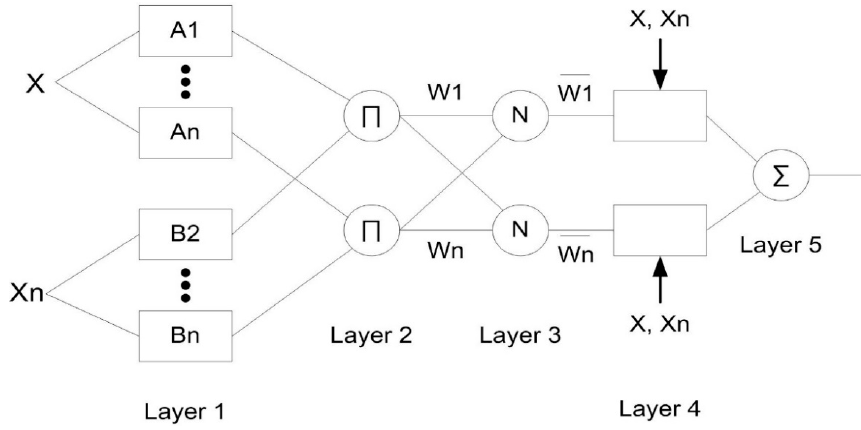
Figure 3. ANFIS model structure.